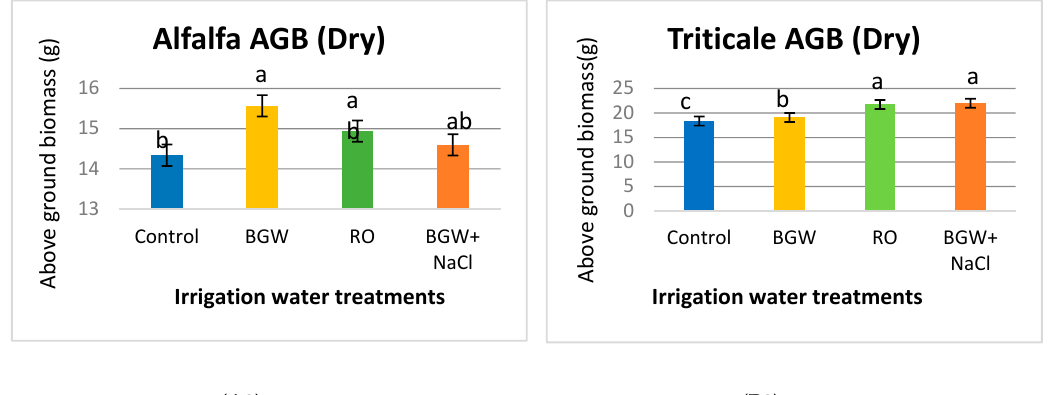
Figure 5. ( A1,A2 ) Aboveground biomass (AGB), fresh and dry, in alfalfa and ( B1 , B2 ) triticale after conclusion of two runs. Means within species sharing the same letter are not significant at α ≤ 0.05. Each observation is the mean ± SEs of four replications. The ECs of the saline treatments were control